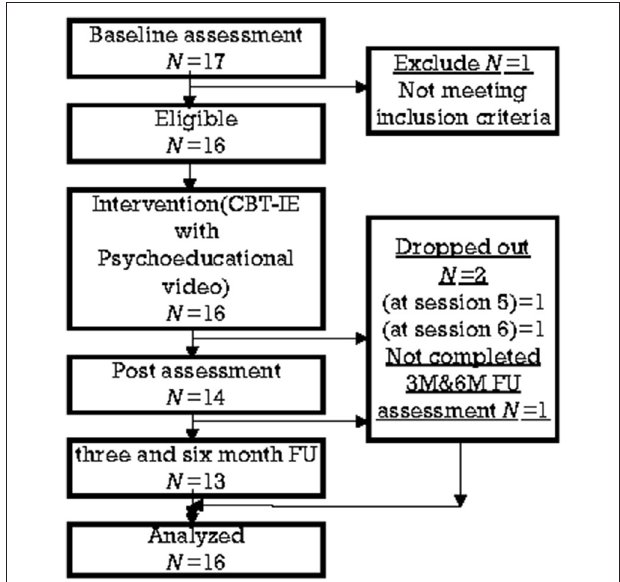
FIGURE 1 | Diagram.